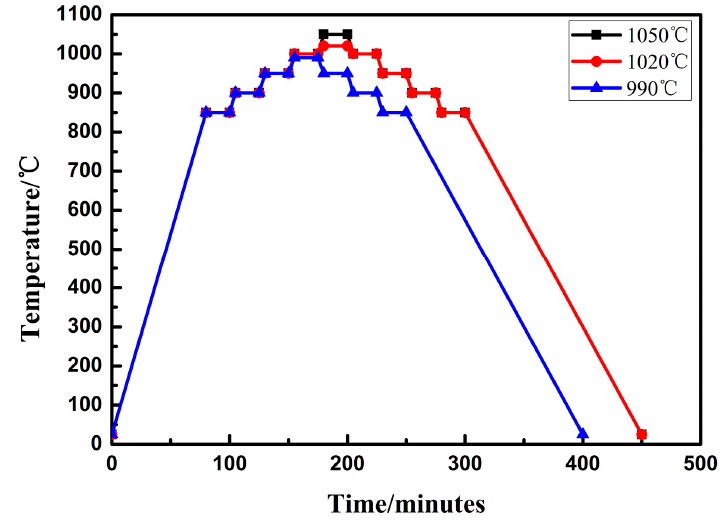
Figure 2. Vacuum annealing process of the coatings.